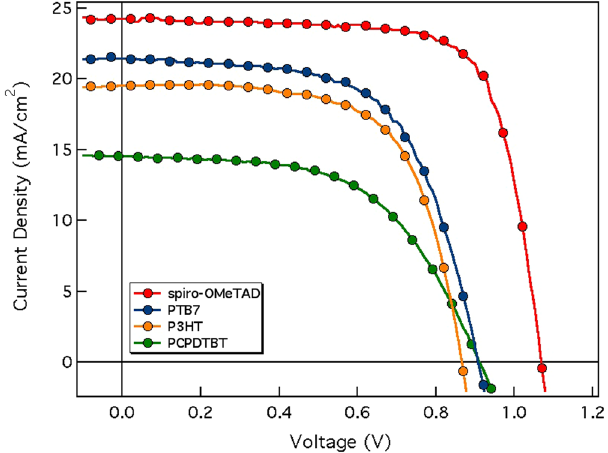
Figure 2. J-V graphs of the devices measured under standard (AM 1.5G) 1 sun conditions from V OC to J SC (champion cells).